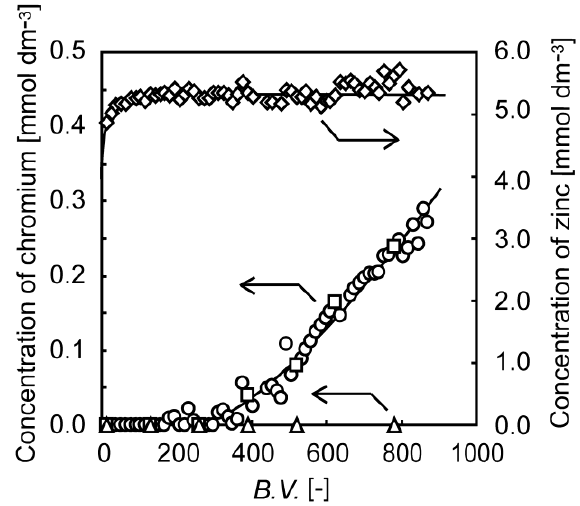
Figure 13. Breakthrough profiles of various chromium and zinc species from the column packed with CPW gel at pH = 4.0 [23] (with permission for reuse from Elsevier B.V.). ○: Total Cr ∆: Cr(III) □: Cr(VI) ◊: